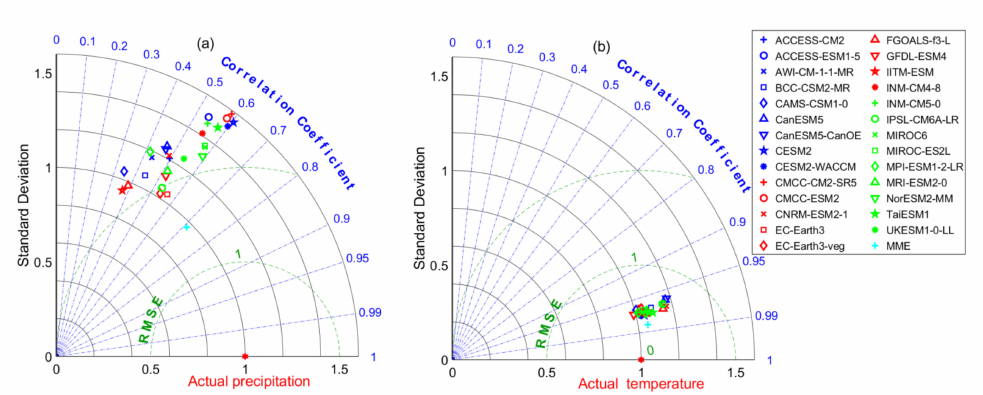
Figure 3. Standardized Taylor diagrams of: ( a ) precipitation and ( b ) temperature. Correlation coefficients (R) between monthly simulations and observations across China were calculated using Equation (1). The standard deviation (SD) between monthly simulations and observations across China was calculated using Equation (2). The root mean square error (RMSE) between monthly simulations and observations across China was calculated using Equation (3). The R, SD, and RMSE are the mean of all pixels across China. The R is plotted in blue, the SD is plotted in black, and the RMSE is plotted in